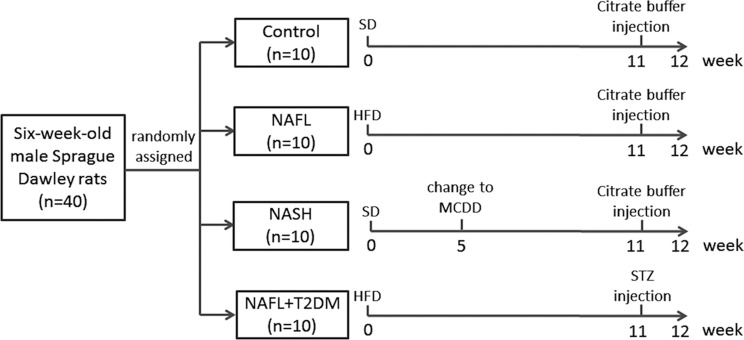
The flow chart of modeling control, NAFL, NASH and NAFL + T2DM rats.The STZ (25 mg/kg in 0.1 M citrate buffer) and citrate buffer were given to rats through a single intraperitoneal injection. SD, standard diet; HFD, high fat diet; MCDD, methionine-choline-deficient diet; STZ, streptozotocin.